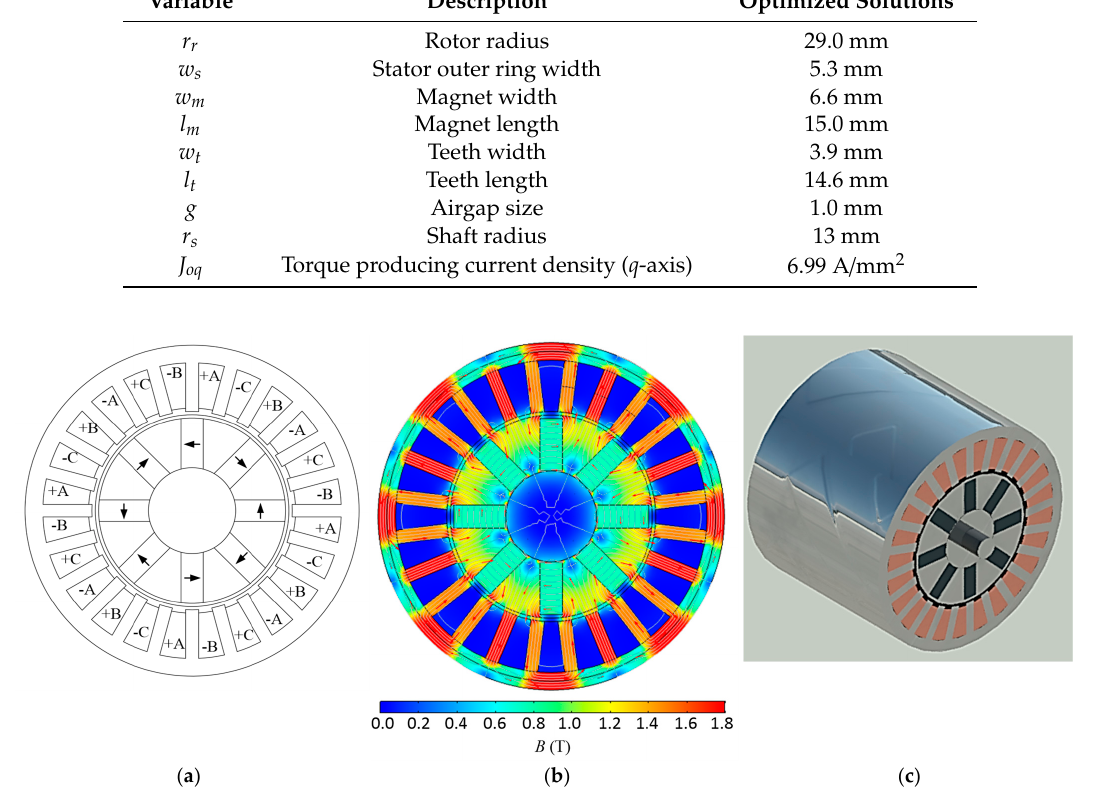
Figure 14. Optimized solution for 20 Nm: ( a ) geometry, ( b ) distribution of magnetic flux density, and ( c ) 3D geometry.